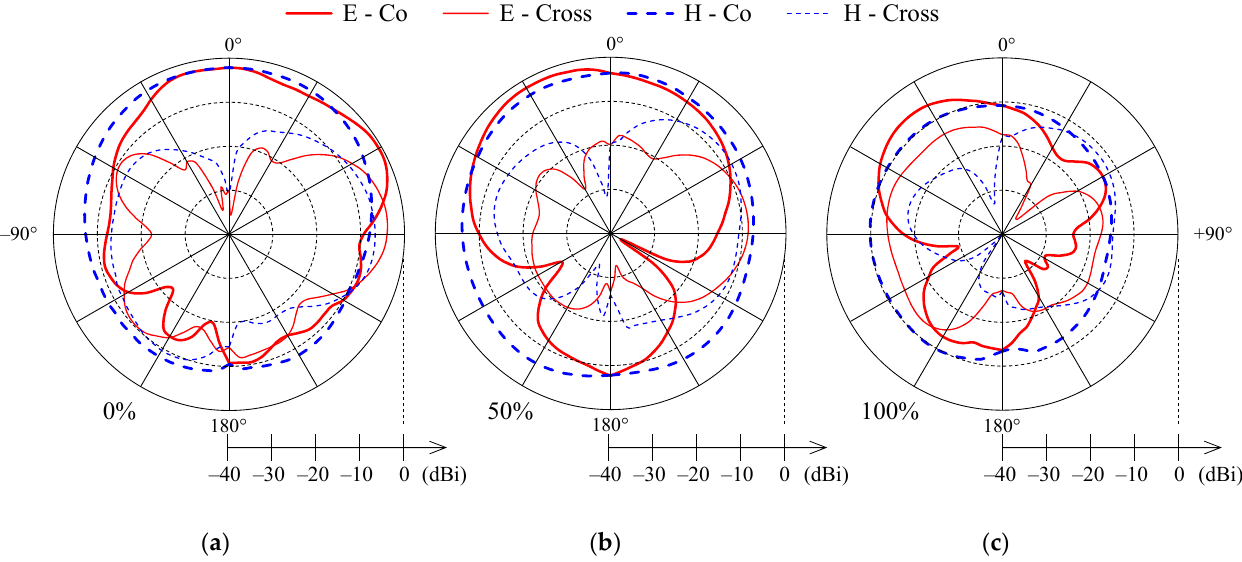
Figure 7. Measured co-polarization (thick line) and cross-polarization (thin line) gain patterns in E-plane (solid) and H-plane (dashed) for the textile PIFA with ( a ) 0% moisture content, ( b ) 50% moisture content, and ( c ) 100% moisture content.